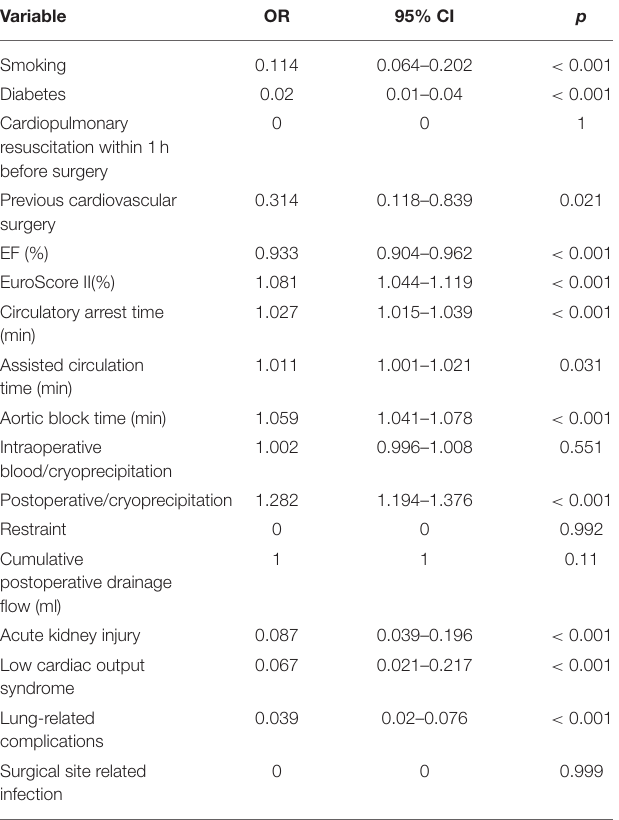
TABLE 2 | Multifactorial analysis of patients with type A aortic dissection ( n = 438).